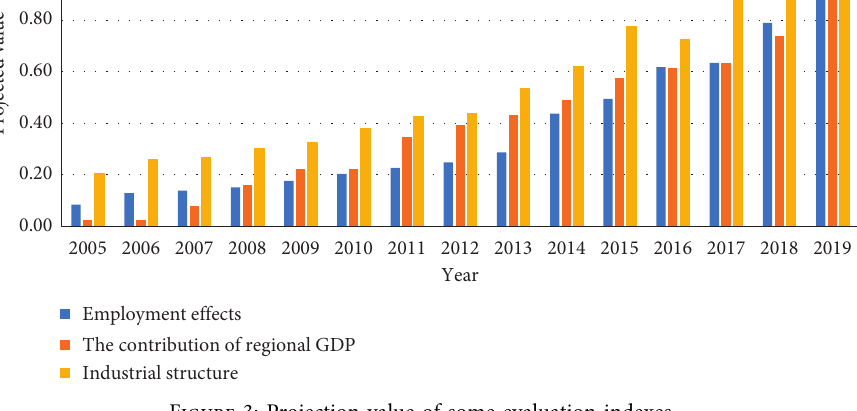
Figure 3: Projection value of some evaluation